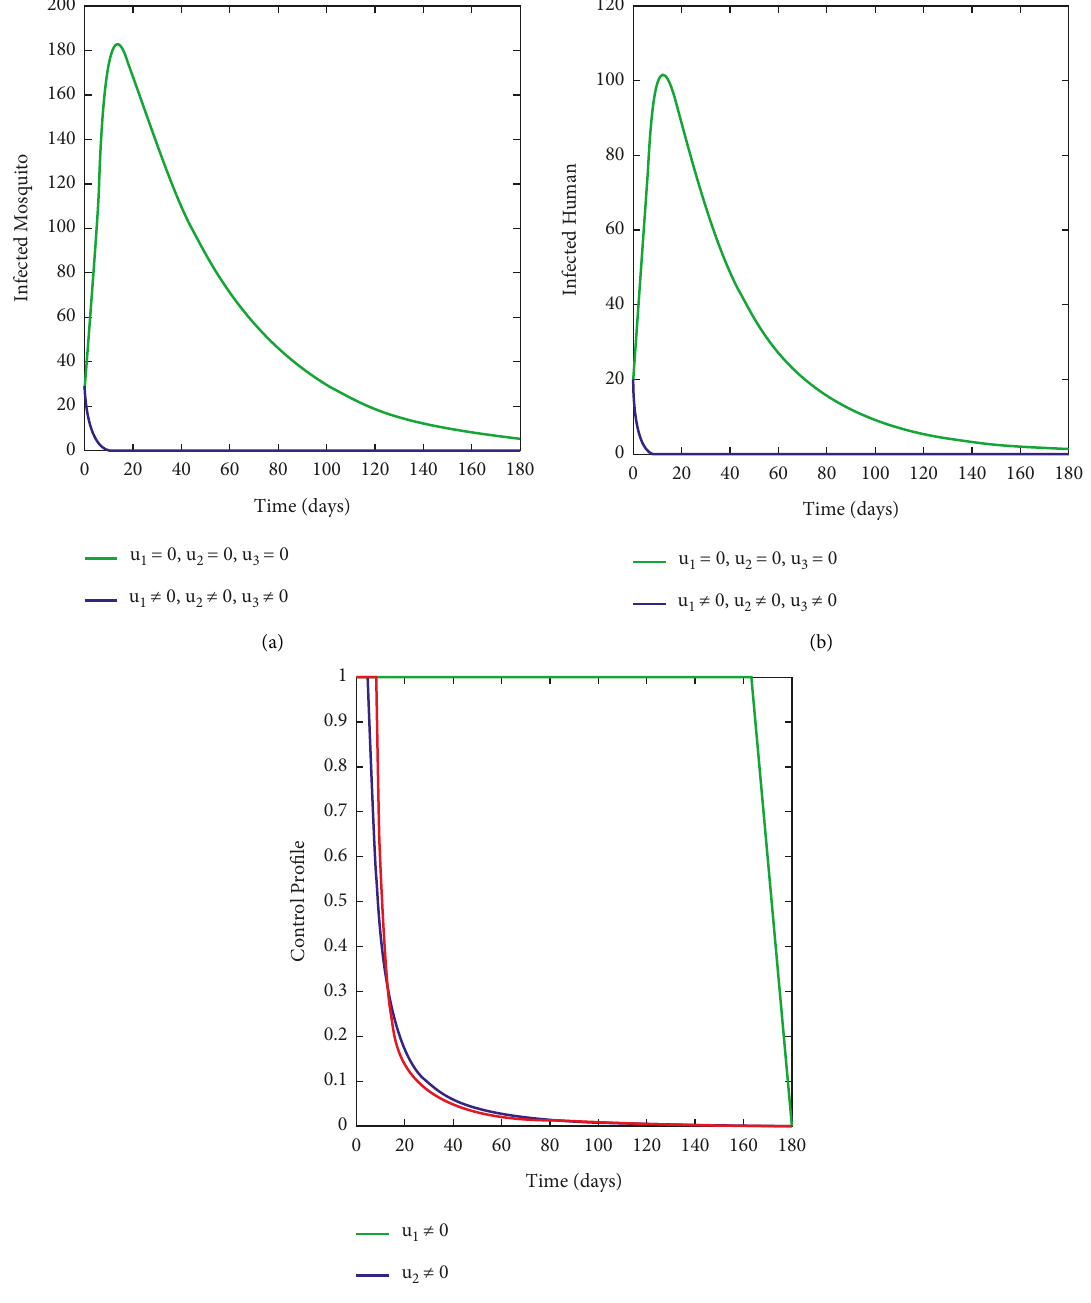
Figure 5: Simulation results indicating treated bed net ( u